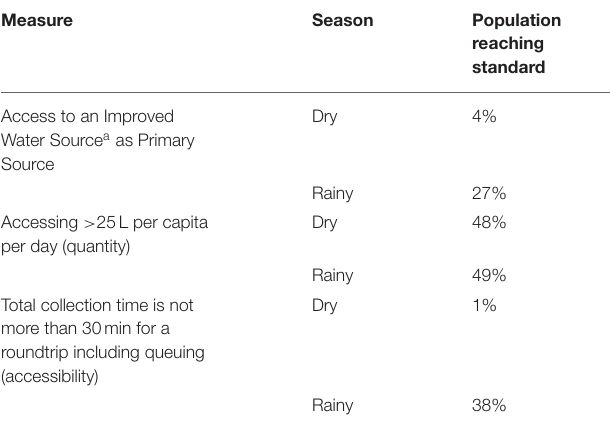
TABLE 2 | Percentage of sample that reports meeting standards for conventional domestic